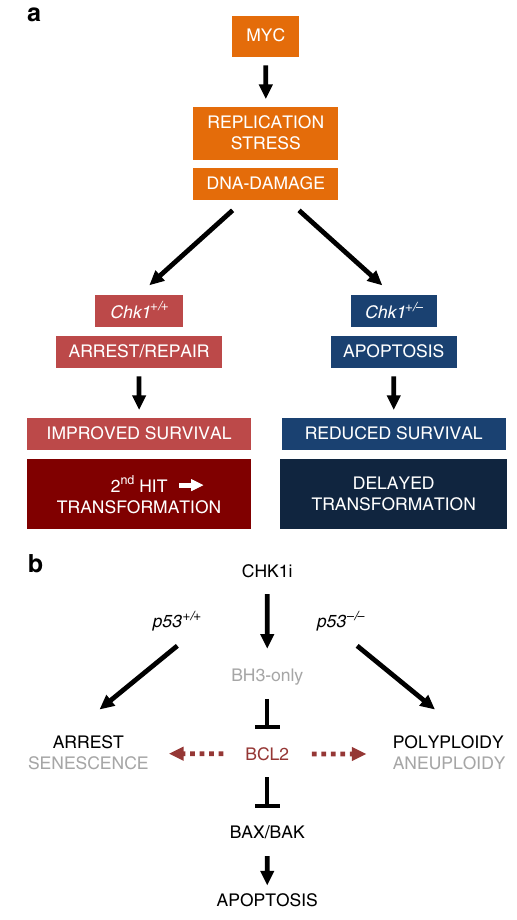
Fig. 8 Proposed model of CHK1 as a facilitator of transformation and drug target. a Lymphocytes rely on CHK1 function to control replication fi delity to avoid DNA damage. In response to oncogenic stress, e.g., the one caused by MYC, replication stress and subsequent DNA damage increase the dependence on CHK1 for successful transformation that, in this model, depends on additional genetic alterations (2nd hit). A reduced CHK1 expression level curtails the cell ´ s ability to effectively deal with oncogene- driven replication stress, leading to increased DNA damage and apoptosis rates, thereby delaying transformation. b CHK1 inhibitors induce cell death in Burkitt lymphoma and ALL cells by engaging the BCL2-regulated BAX/ BAK-dependent apoptosis pathway, kick-started by yet to be de fi ned BH3- only proteins. Cell fate in response to inhibitor treatment is fi ne-tuned by p53 status and intrinsic apoptosis thresholds, controlled by the BCL2 family. Impaired cell death, e.g., due to BCL2 overexpression can deviate the cellular response to p21-mediated cell death, and, potentially senescence, when p53 is functional. Yet, in the absence of p53, cell death and cell